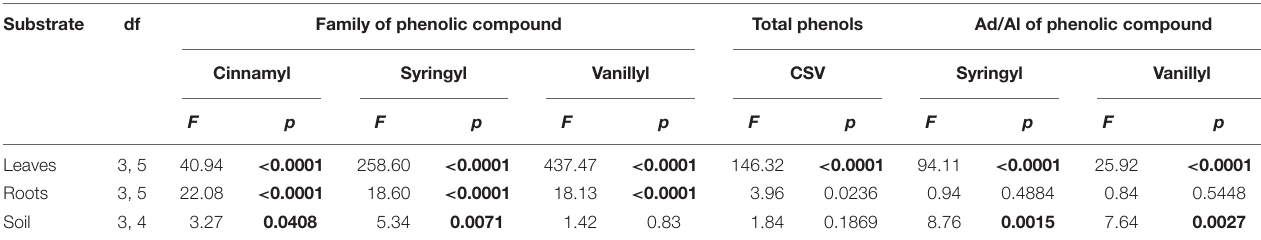
TABLE 2 | Summary table of ANOVA results for families of phenolic compounds and their Acid/Aldehyde (Ad/Al) ratios in six tropical tree species. Substrate